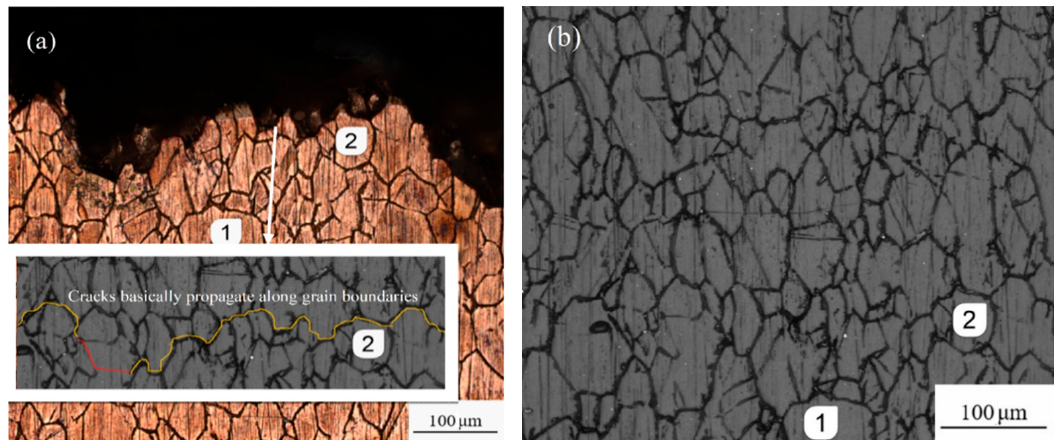
Crack length a (μm) Figure 10. Fitting curve of crack growth rate as function of crack length. (a) (b) Figure 11. Curve of crack growth rate as function of crack length: ( a ) TC specimens; ( b ) RB specimens. To further determine the fracture mode of the specimens, Figures 12 and 13 present the fracture